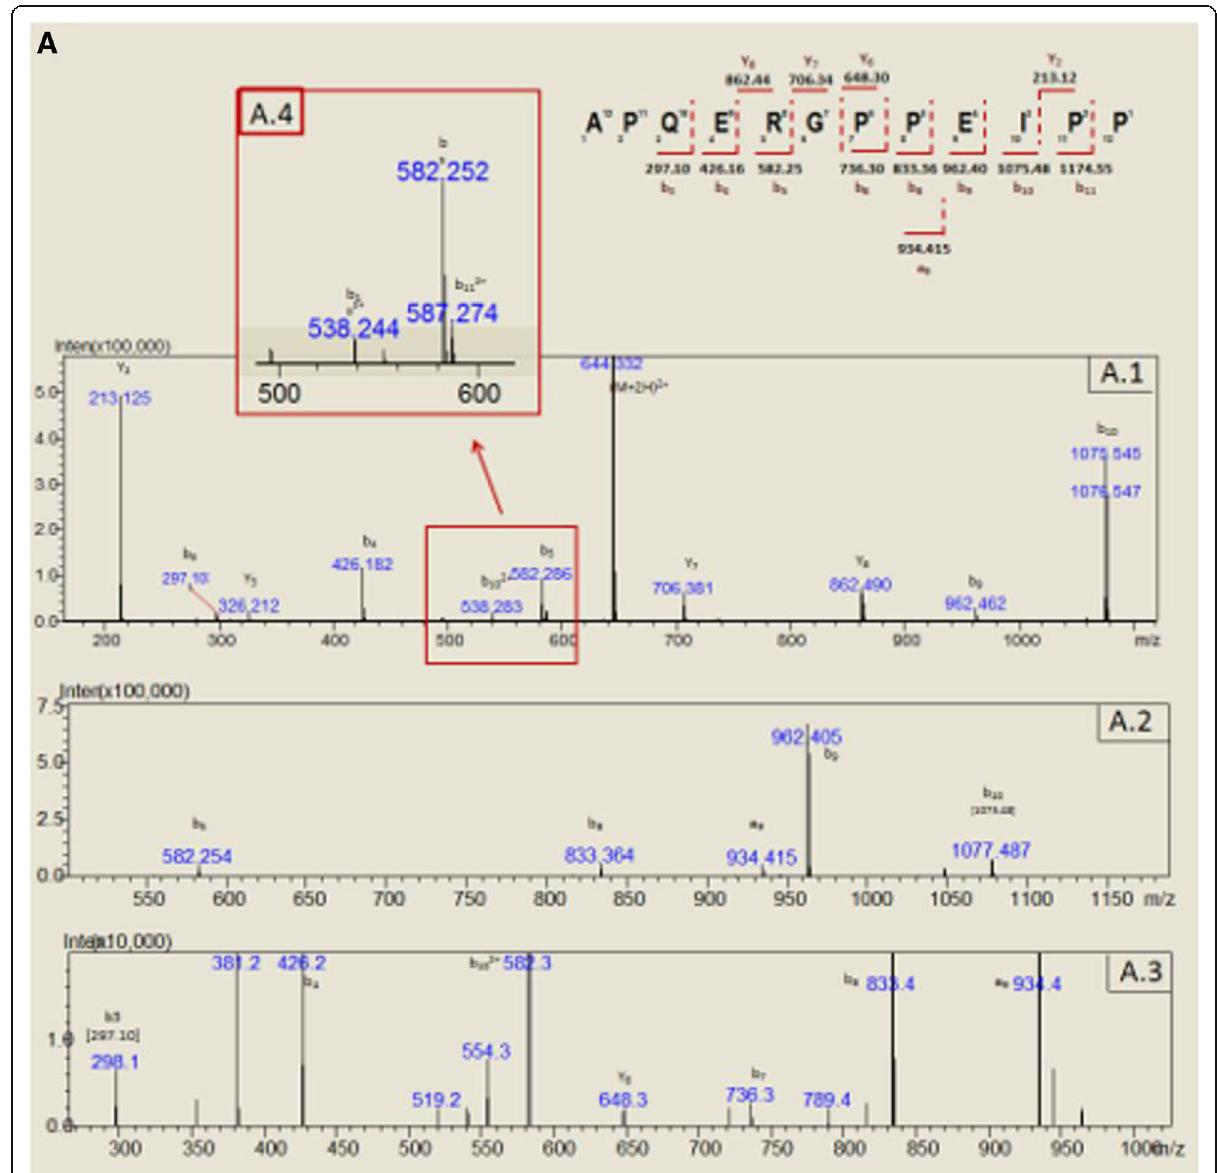
Fig. 3 Representative CIF spectra of m/z = 644.30 [M + 2H] 2+ , (A.1) MS 2 for m/z = 644.30, (A.2) MS 3 for m/z = 1075.545, (A.3) MS 4 for m/z = 962.405, (A.4) magnification of A.2 and respective annotations and sequence